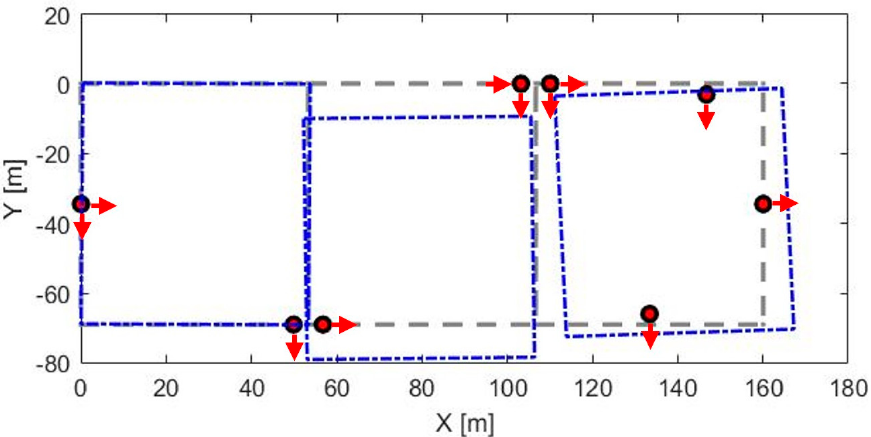
Figure 13. Identified mode shape #1 at 2.57 Hz (horizontal